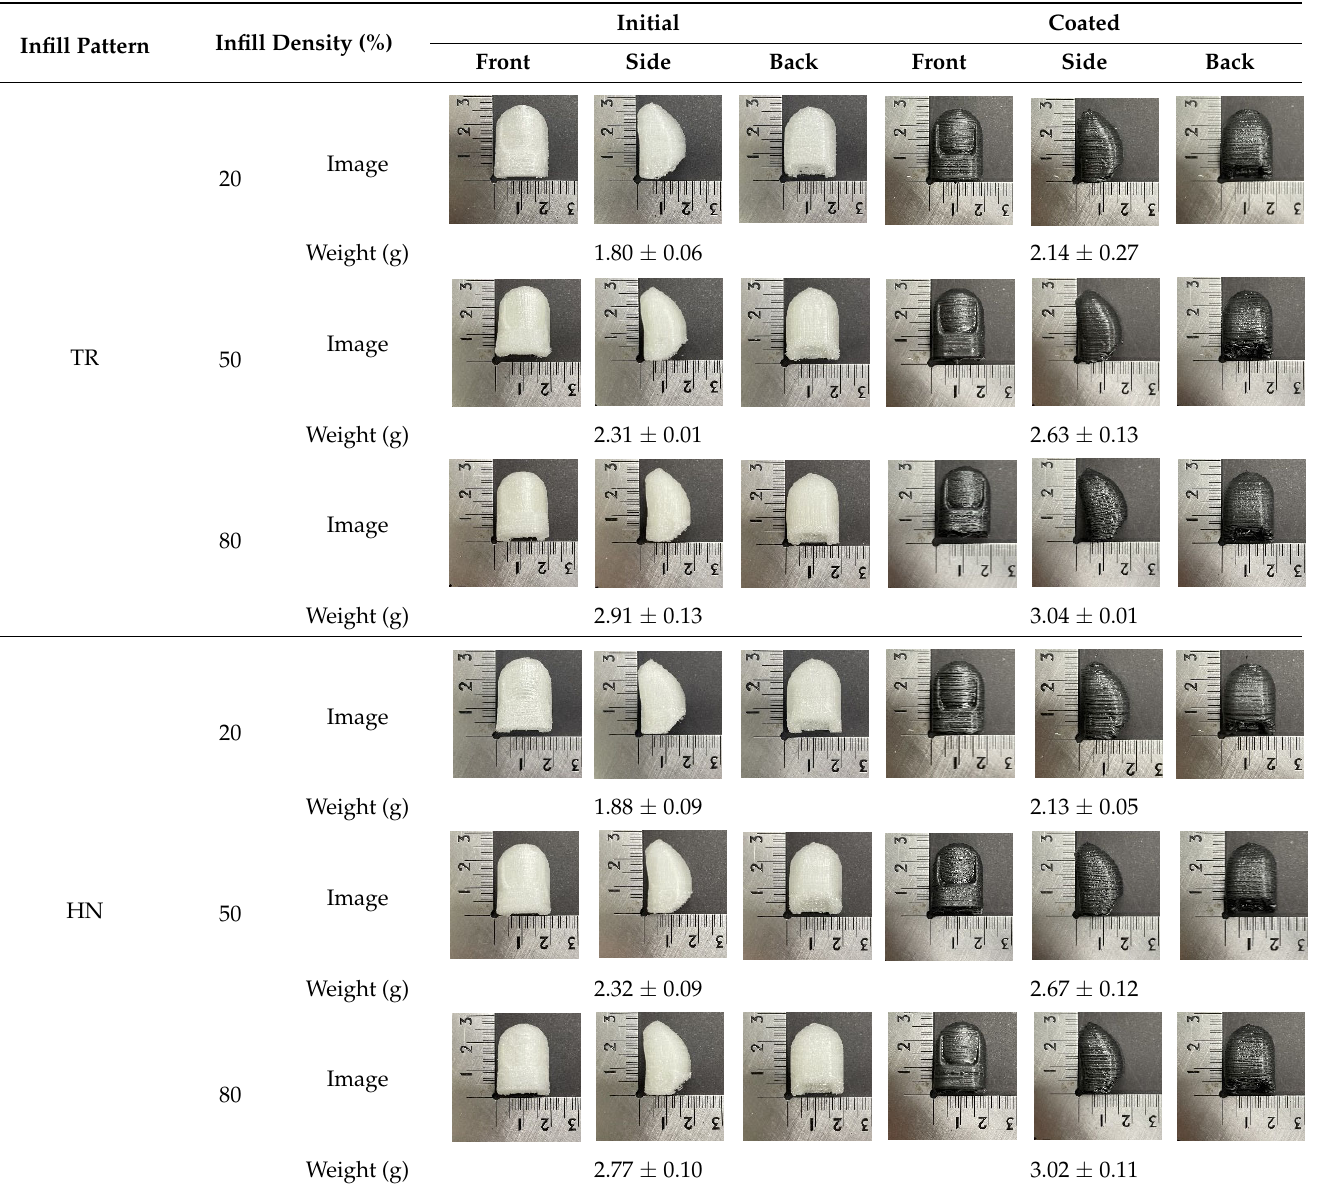
Table 2. Sample images of 3DP fi ngertips and coated 3DP index fi ngertips under various in fi ll pat- terns and densities. In fi ll Pa tt ern